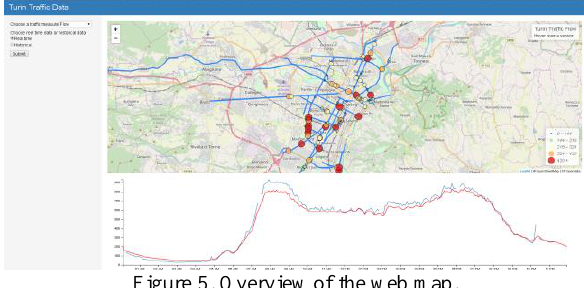
Figure 5. Overview of the web map.